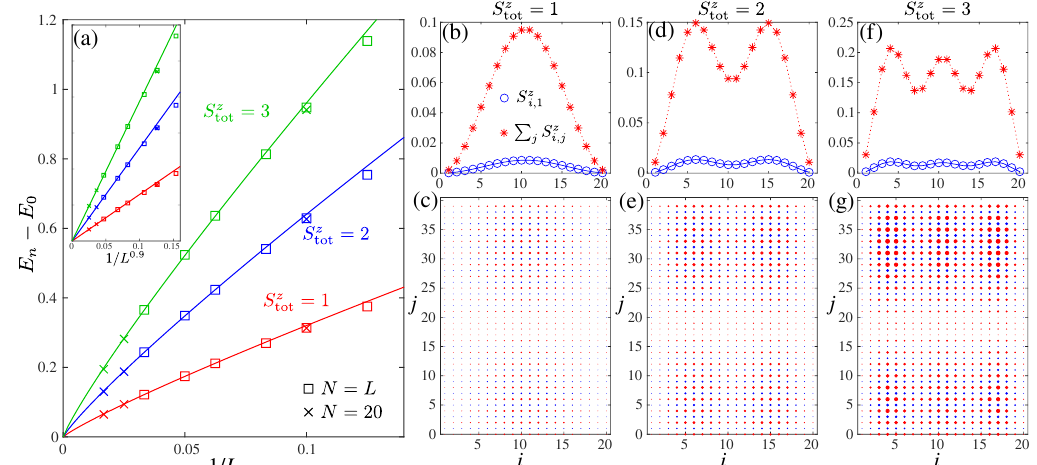
Figure 4: (Color online) Magnetic excitations in a weak-backbone regime. (a) Scal- ing of the energy difference between the lowest energy state in the sector of total = 1,2,3 and the ground-state in the sector S z = 0 as a function magnetization S z tot tot of the inverse of the tooth length 1 / L . The symbols are the DMRG data, the red line is the result of the fit of the singlet-triplet gap with ∝ L − d app , and the blue (green) line is the result of the fit multiplied by an integer 2 (3). Inset: The same plot, but as a function of 1 / L 0.9 . (b-g) The distribution of local magnetization on a comb lattice with L = 40 and N = 20. (b), (d), (f) The local magnetization on the backbone (blue circles) and total magnetization of a tooth as a function of tooth index (red stars). (c), (e), (g) Local magnetization, with the size of the circles proportional to the ab- solute value of the magnetization, and with red and blue colors signifying positive and negative signs of